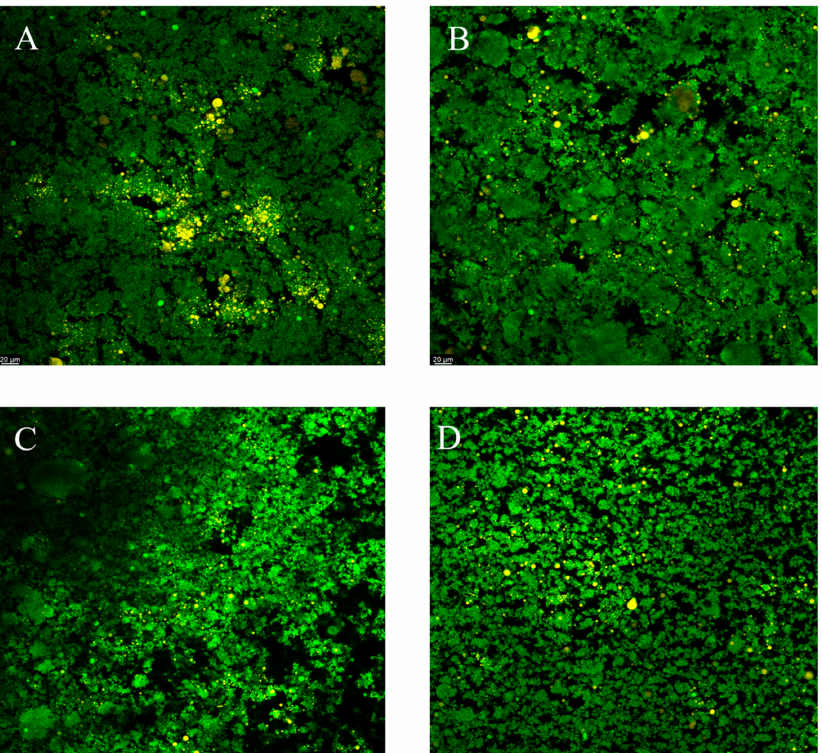
Figure 2. Confocal laser scanning microscopic images of yogurts. CY—Control yogurt without fucoxanthin; FXY—Yogurt with fucoxanthin at 0.052 mg/g of yogurt mix. ( A ) CY at week 0. ( B ) CY at week 4. ( C ) FXY at week 0. ( D ) FXY at week 4. Imaging was performed in a line sequential mode. Micrographs are presented as an overlay. The proteins networks are green, and the fat globules are yellow. Scale bar 20 µ m.